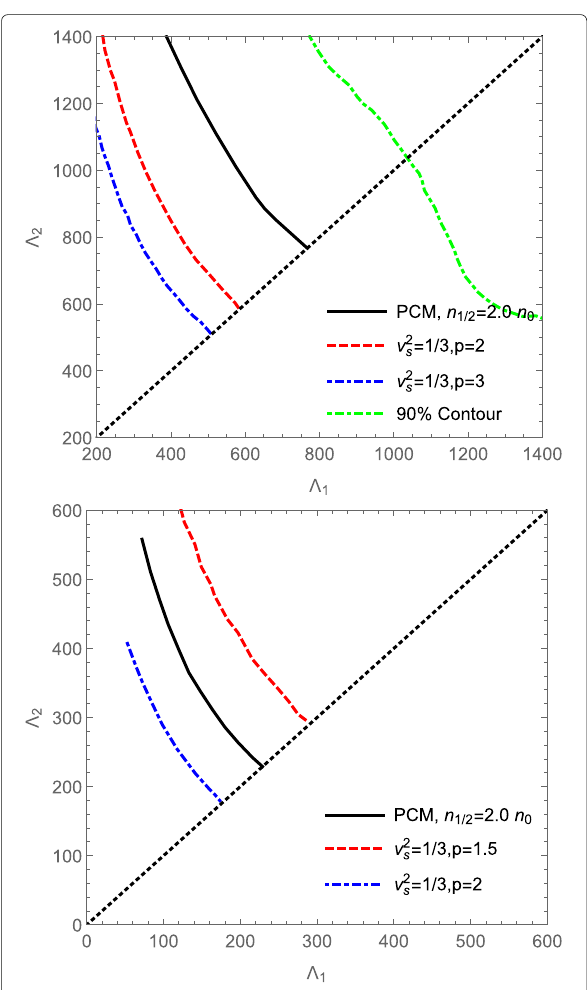
Fig. 10 Tidal deformabilities (cid:20) 1 and (cid:20) 2 associated with the high-mass M 1 and low mass M 2 components of the binary neutron star system GW170817 with chirp mass 1.188 M (cid:3) (upper panel) and GW190425 with chirp mass 1.44 M (cid:3) (lower panel). The constraint from GW170817 at the 90% probability contour is also indicated